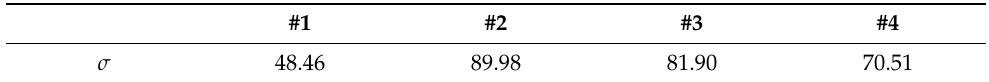
Table 7. σ of the four reactive